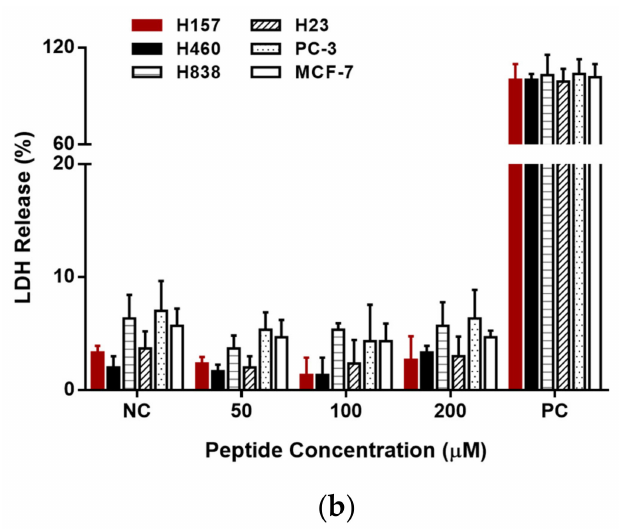
Figure 6. Cytotoxicity evaluation of SL-BBI and its analogues on di ff erent cell lines. ( a ) The MTT cell viability test on H157, H460, H838, H23, PC-3, U251MG, MCF-7, HCT-116 and HMEC-1 cells under di ff erent concentration after 24 h treatment. The 100% cell viability was applied with growing cells without peptides and a positive control group was treated with 1 mM 5-FU. ( b ) The LDH cytotoxicity results of F-SL on H157, H460, H838, H23, PC-3 and MCF-7. The 100% LDH release of the positive control group was applied with 1% Triton X-100 and negative control group was acquired after treated with culture medium. The error bar represents the S.E.M. (standard error of the mean) of 9 replicates and the levels of significance are: * p < 0.05, ** p < 0.01, *** p < 0.001, **** p < 0.0001. Table 4. The calculated IC50 values of F-SL on di ff erent human cell lines based on MTT results.